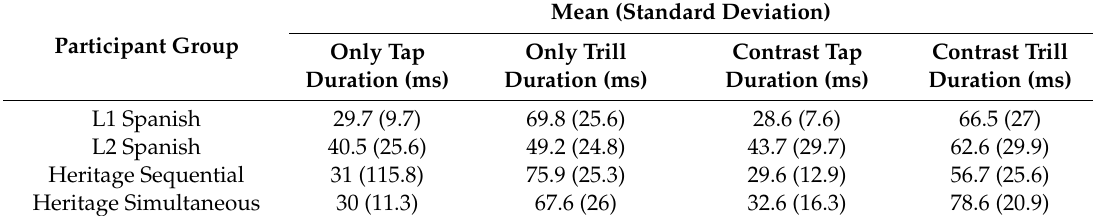
Descriptive statistics according to rhotic duration in milliseconds and number of apical occlusions.